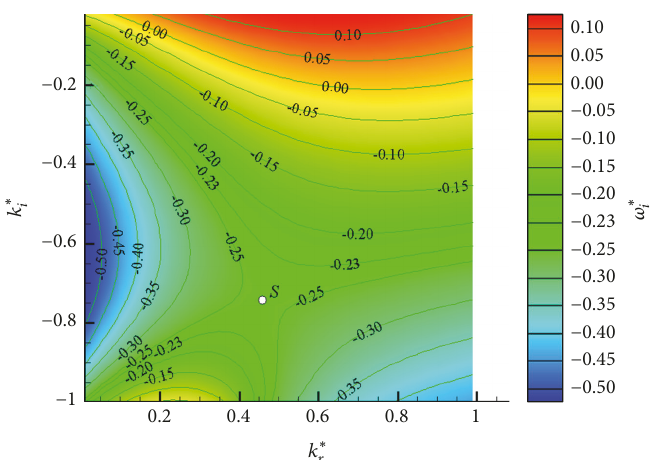
Figure 2: Contours of 𝜔 ∗ 𝑖 = constant in the complex 𝑘 ∗ plane ( Λ = 1 , 𝜙 = 0 , 𝑀 = 0 , 𝑆 𝑇 = 5